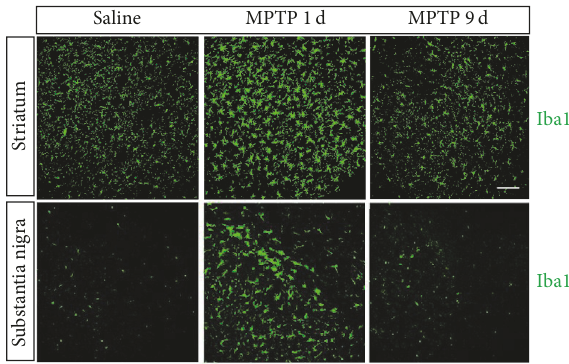
Figure 2: Microglial cells in the nigrostriatal pathway at 1 and 9 days after acute MPTP treatment. Immunofluorescence staining for Iba1 (green) in the striatum and in the SN was shown. Scale bar: 0.1 mm. This figure is adapted from Liu et al., scientific reports 5:15720